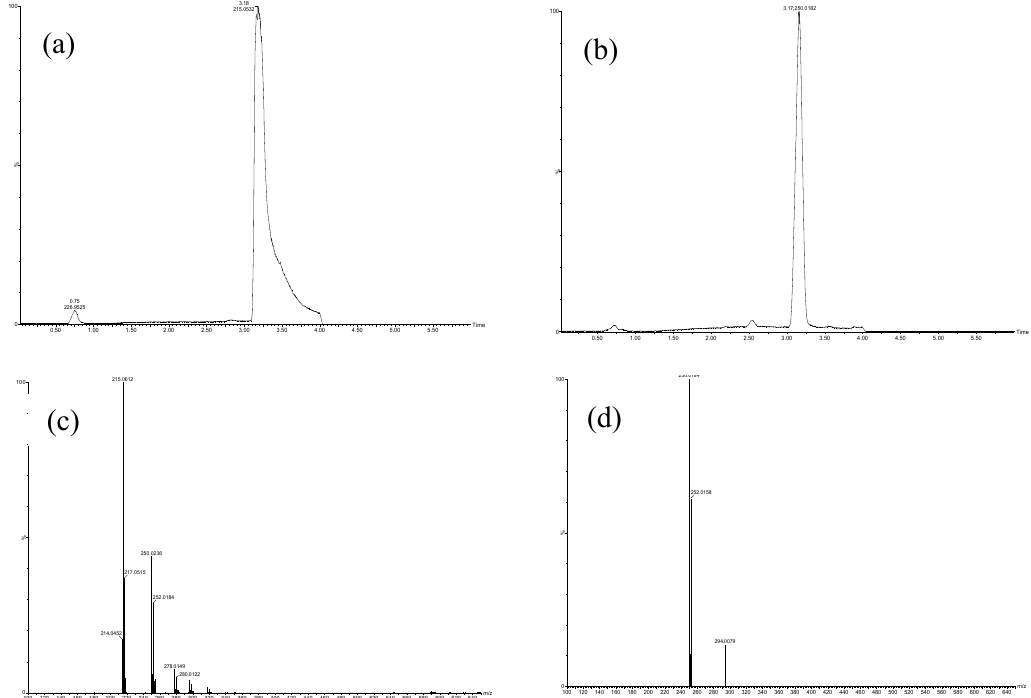
Figure 3. High-performance liquid chromatography (HPLC)– mass spectroscopy (MS) chromatographic patterns of DIC standard. ( a ) Total ion chromatogram (TIC) in the ESI+ mode, ( b ) TIC in the ESI− mode, ( c ) MS patterns in the ESI+ mode, and ( d ) MS pa(cid:308)erns in the ESI− mode.